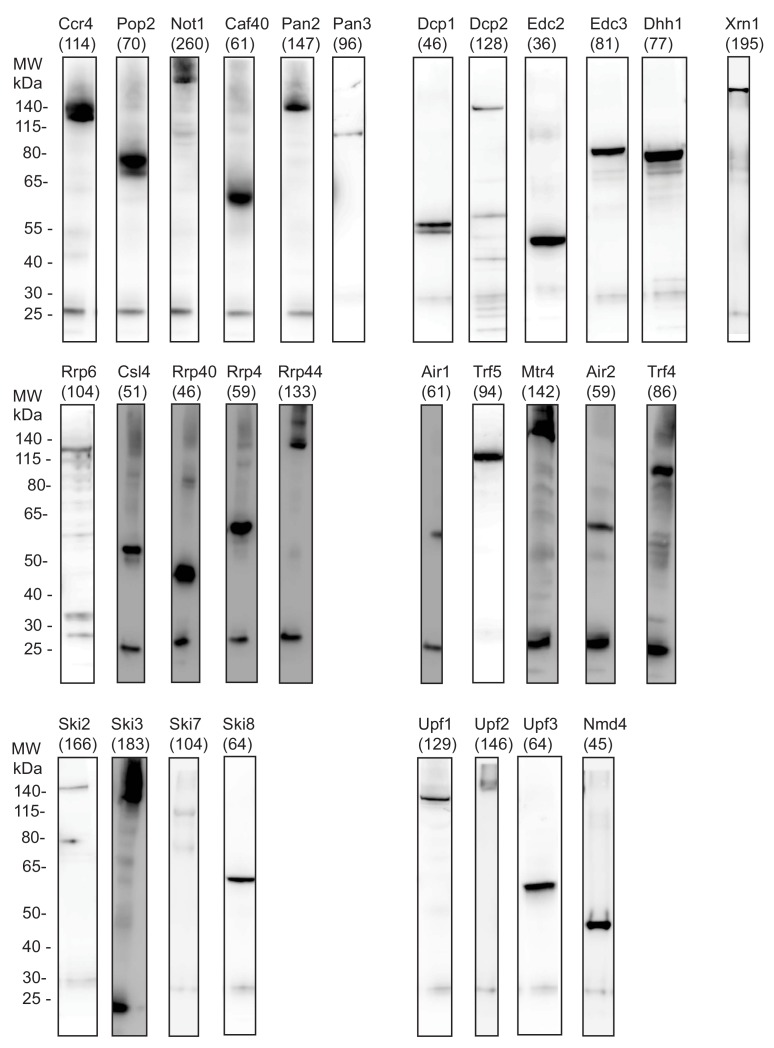
Western Blot analysis for all degradation factors analyzed in this study show IP efficiency.IP using the TAP-tag is detected by Western Blot analysis with tag specific antibody to show the IP quality of the different PAR-CLIP experiments representative for one replicate per factor. The factors are sorted according to their complexes: deadenylation (Ccr4, Pop2, Not1, Caf40, Pan3, and Pan3), decapping (Dcp1, Dcp2, Edc2, Edc3, and Dhh1), 5´→3´ exonuclease (Xrn1), exosome (Rrp6, Csl4, Rrp40, Rrp4, and Rrp44), TRAMP (Air1, Trf5, Mtr4, Air2, and Trf4), Ski (Ski2, Ski3, Ski7, and Ski8), and NMD (Upf1, Upf2, Upf3, and Nmd4). The molecular weight including the weight of the TAP tag (in kDa) is indicated for each factor. The band at ~25 kDa is caused by cross-reactivity of the light chain of the used antibodies for IP and Western Blot. A shift to higher molecular weight than indicated can be caused by UV-crosslinking of proteins to RNA.